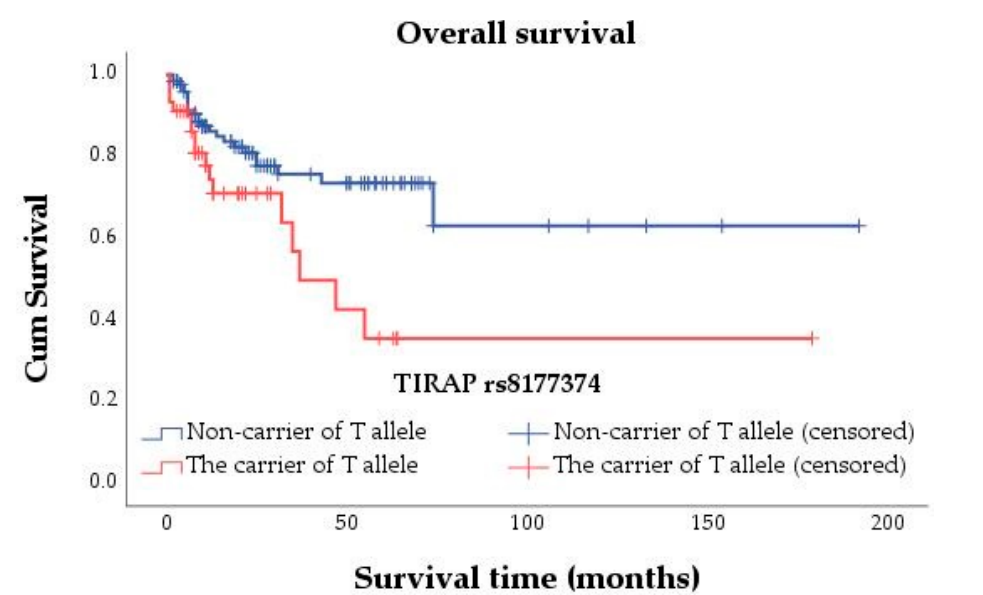
Figure 1. Kaplan–Meier survival curve for the association between the A allele of rs3802814 and OS.